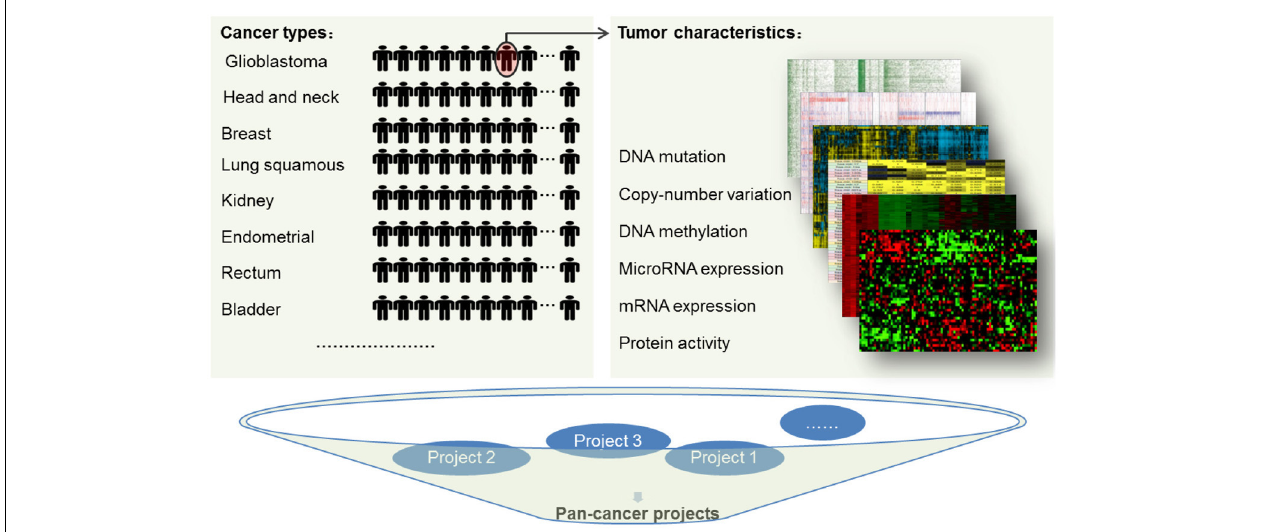
FIGURE 1 | Multiple omics datasets from diverse tumor types enable comprehensive analyses on numerous aspects of cancer genomics. The pan-cancer data includes rich biomolecular profiles on six types of platforms (mutation, copy number, methylation, gene expression, microRNA and reverse phase protein arrays) from tumors occurring in different sites of the